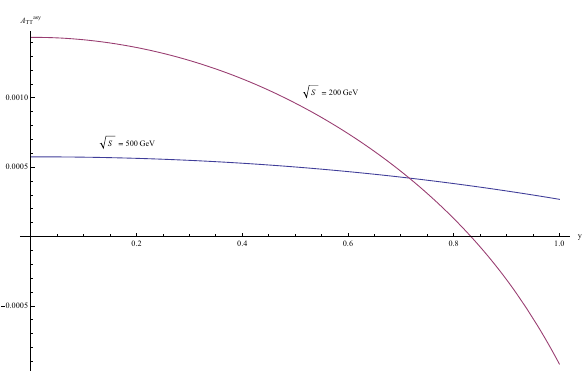
Fig. 8 Azimuthal asymmetry related to heavy quark charge asymme- try, i.e., A asy . E 1 ⊥ = 10GeV and μ = E 1 ⊥ are taken in the TT